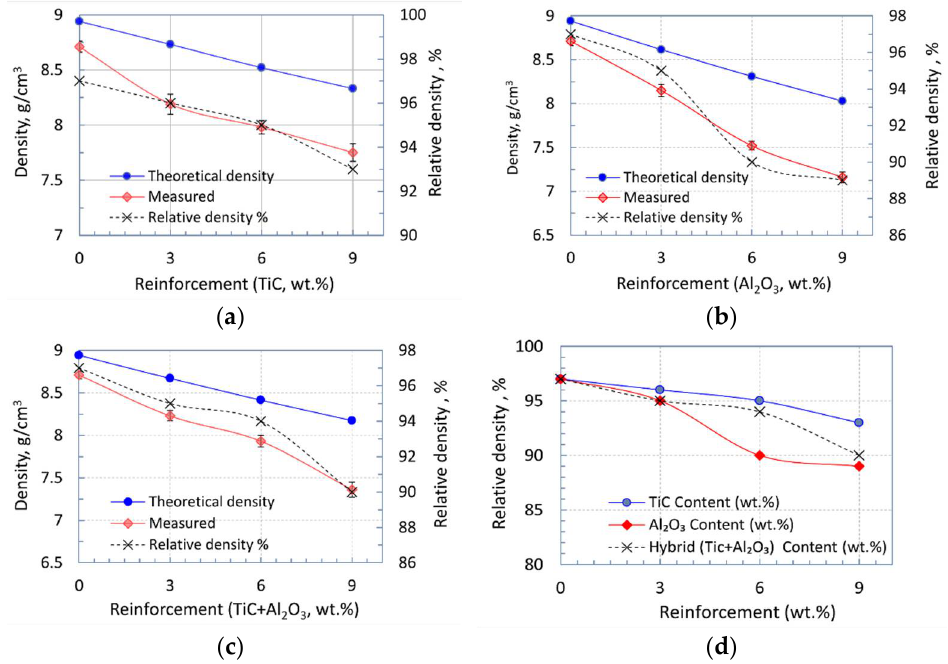
Figure 4. The effect of reinforcement fraction on the density of the produced composites. ( a ) Cu/TiC composites, ( b ) Cu/Al 2 O 2 composites, ( c ) Cu/hybrid composite, and ( d ) Comparison of relative density between three